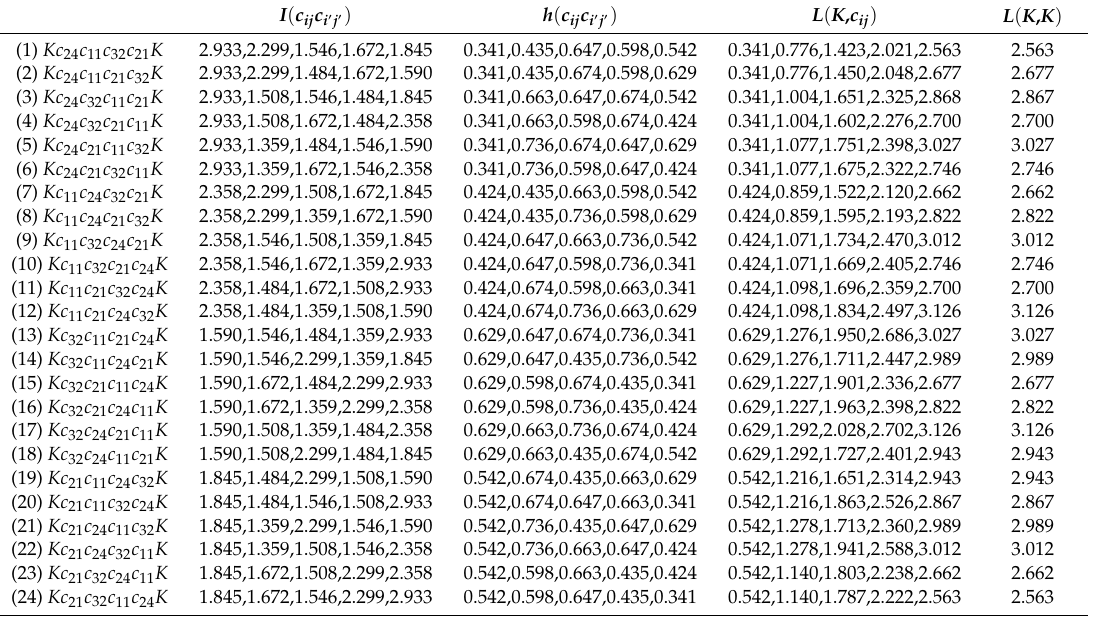
Table 6. Sub-unit motive weight value h ( · ) and generation tree weight function value L ( · ) .